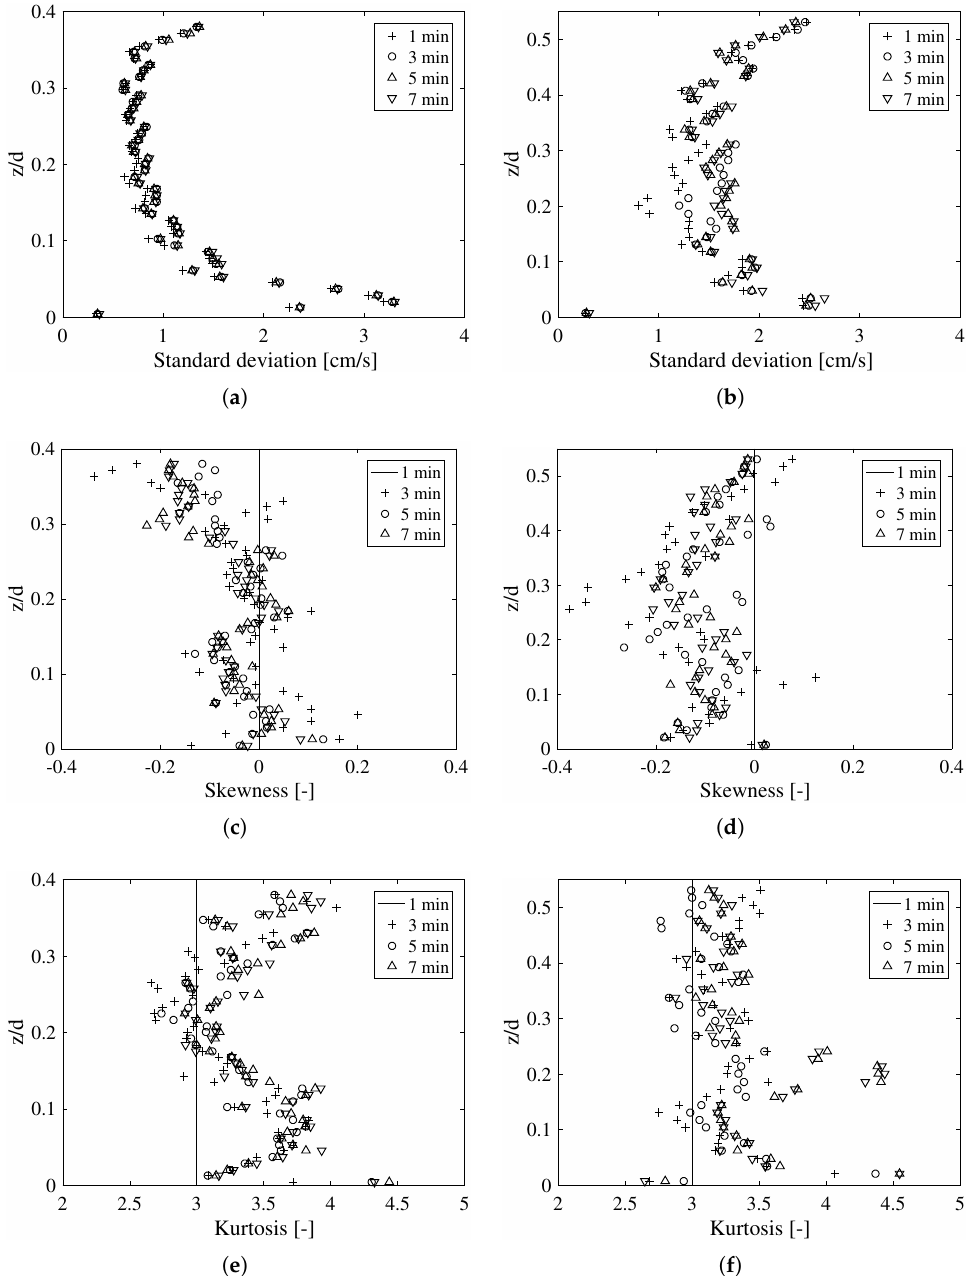
Figure 6. T 9 test ( H = 5.86 m, T = 1.26 s), velocity statistics profiles convergence: ( a ) standard deviation at P 1 , L 2 ; ( b ) standard deviation at P 2 , L 2 ; ( c ) skewness at P 1 , L 2 ; ( d ) skewness at P 2 , L 2 ; ( e ) kurtosis at P 1 , L 2 ; and ( f ) kurtosis at P 2 , L 2